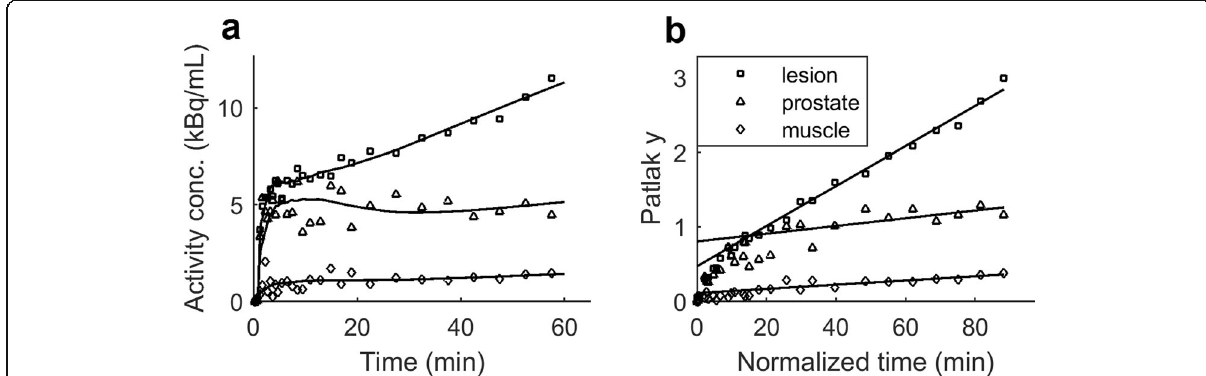
Fig. 5 Typical 68 Ga-PSMA-11 time activity curves and the corresponding irreversible two-tissue compartment model fits ( a ). Patlak graphical analysis presented positive slopes from 15 min post-injection for all regions ( b ) Table 3 summarizes the SUV correlation analysis. Le-